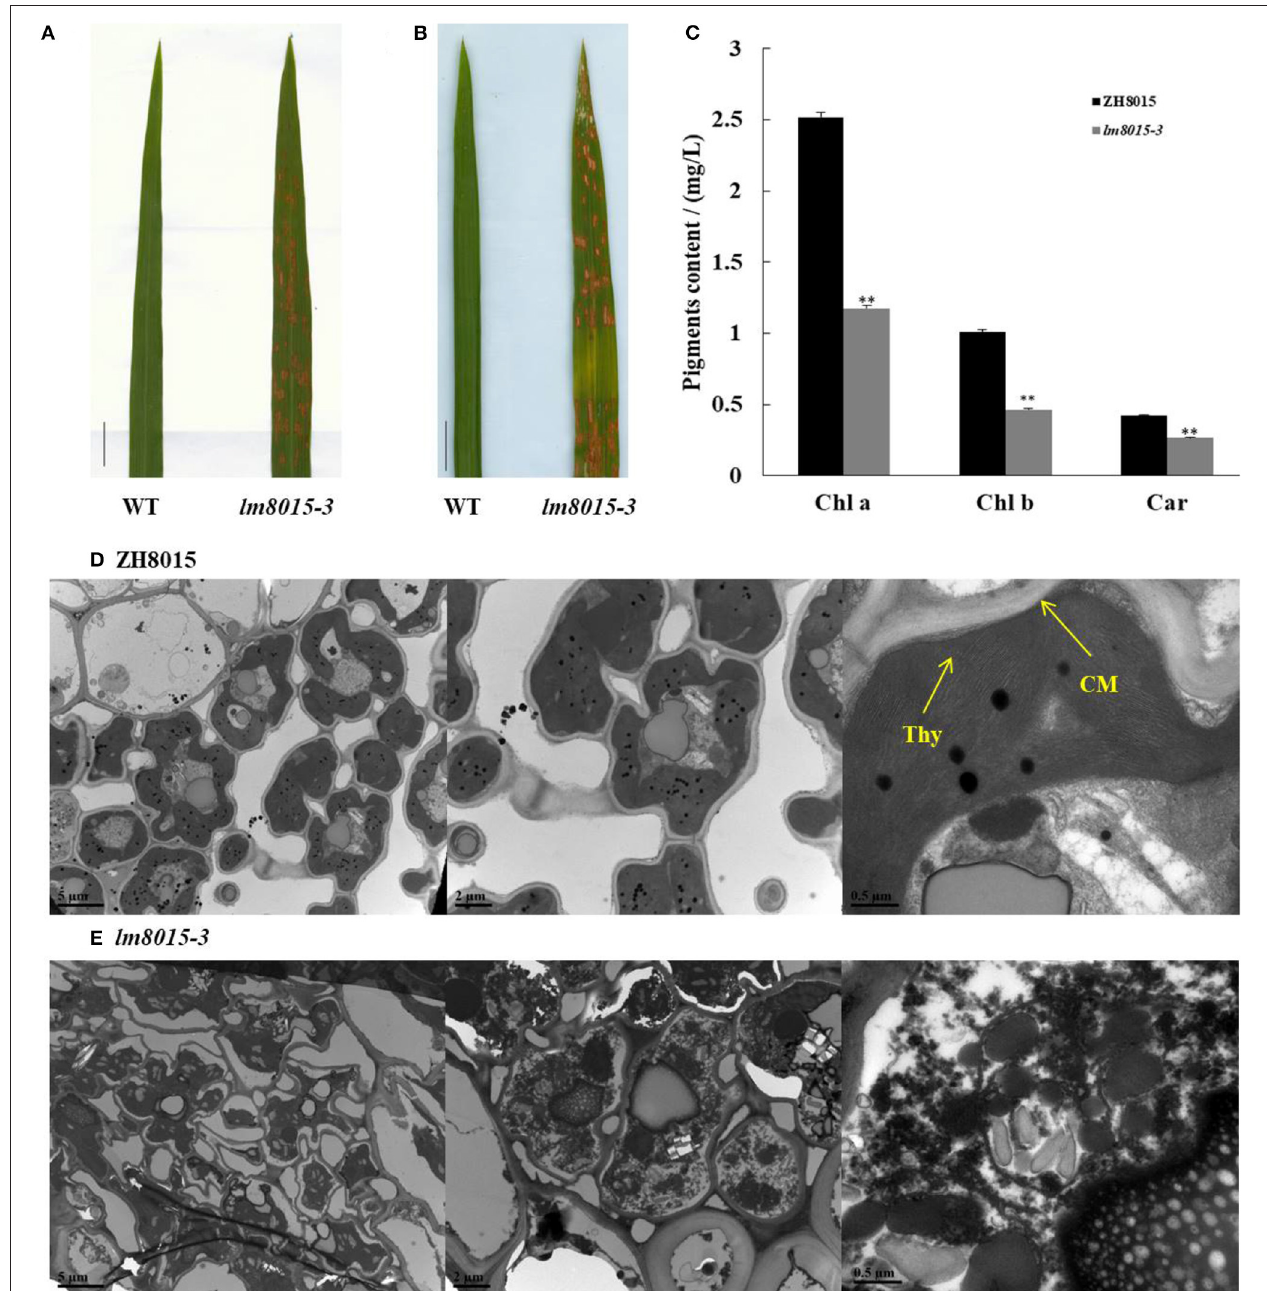
FIGURE 2 | Identification of leaves of lm8015-3. (A,B) Shading experiment of the second top leaves of ZH8015 and lm8015-3 at the tillering stage. The leaves were exposed to light, and the leaves in (B) were covered with foil for 7 days; scale bar = 2cm. (C) Determination of pigment contents of ZH8015 and lm8015-3 at the tillering stage. **Significant at P < 0.01 ( t -test); Error bars represent SD ( n = 3). (D,E) TEM observation of the chloroplasts in ZH8015 (D) and lm8015-3 (E) at the tillering stage. Thy, thylakoid lamellae; CM, chloroplast